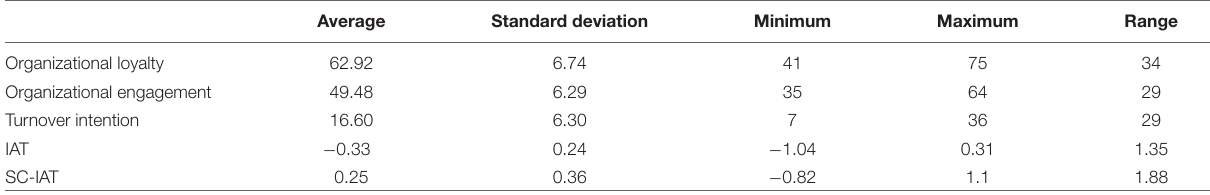
TABLE 4 | Correlation of total.